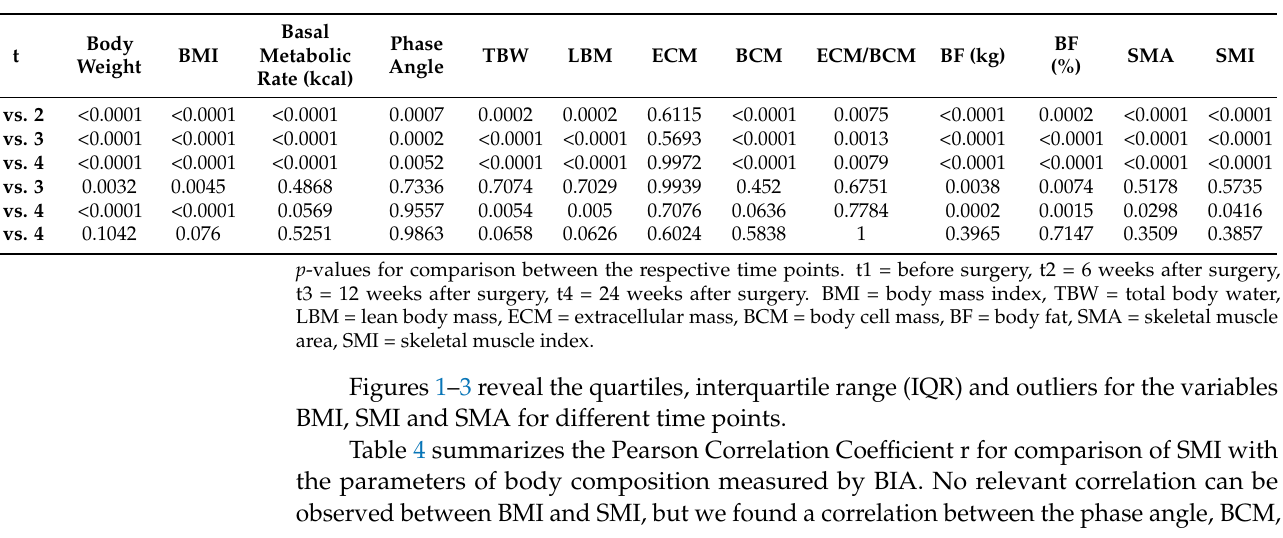
Table 3. Comparison of BIA parameters between the different time